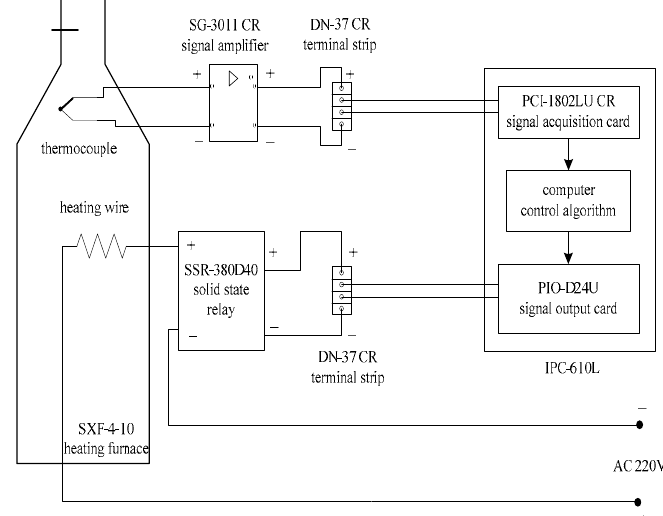
Figure 3. The electric heating furnace SXF-4-10.